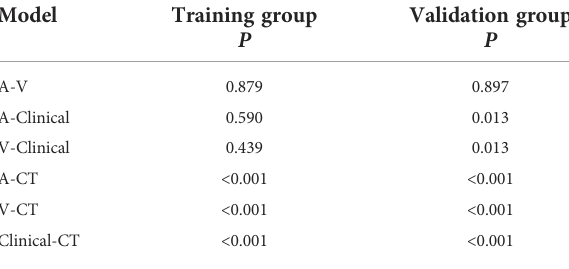
TABLE 5 Comparison of AUC results among models by the Delong